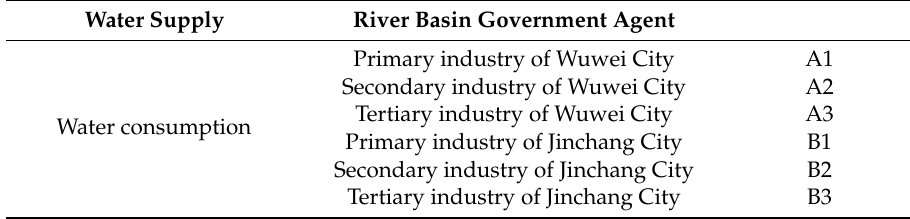
Table 3. Summary of the main agents in the Shiyang River